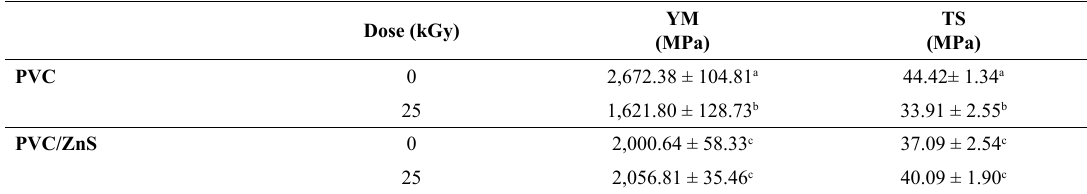
Table 3. Mechanical results obtained for PVC and PVC/ZnS.